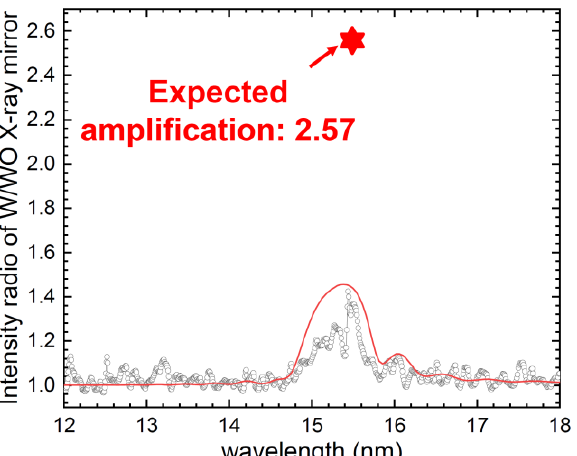
Figure 5. Improvement of the gain coefficient by means of the single resonator. The values expected from the coupling efficiency, mirror reflectivity, and gain and the fitting curve of the experimental data based on the mirror reflectivity are also plotted.